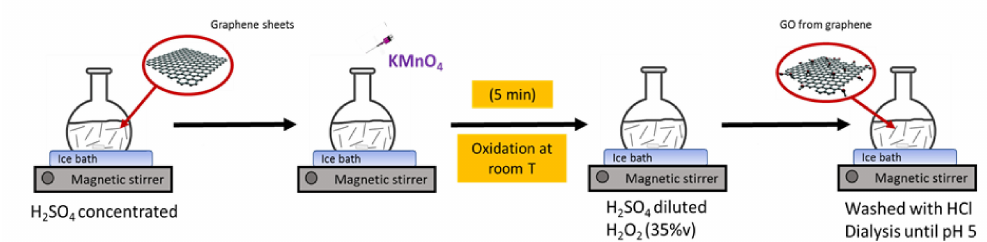
Figure 1. Schematic representation of the rapid synthesis (5 min of oxidation) of graphene-oxide obtained directly from graphene